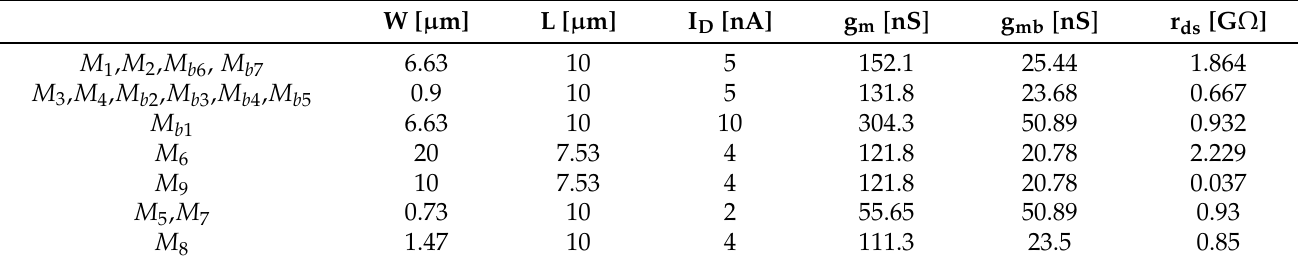
Table 1. Nominal transconductance, sizing and output resistance of